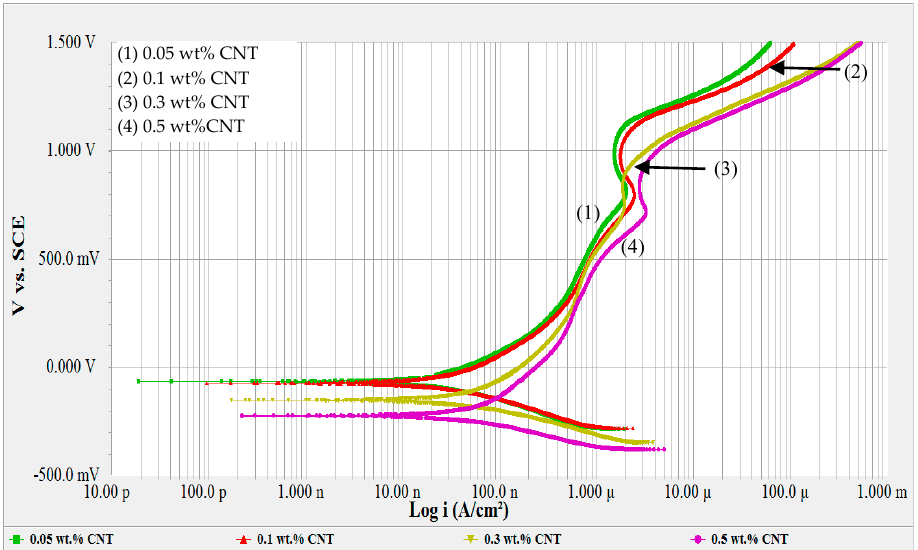
Figure 1. Potentiodynamic scans for 316L stainless steel (SS) exposed to 0.05, 0.1, 0.3 and 0.5 wt% CNT-water nanofluids at room temperature.